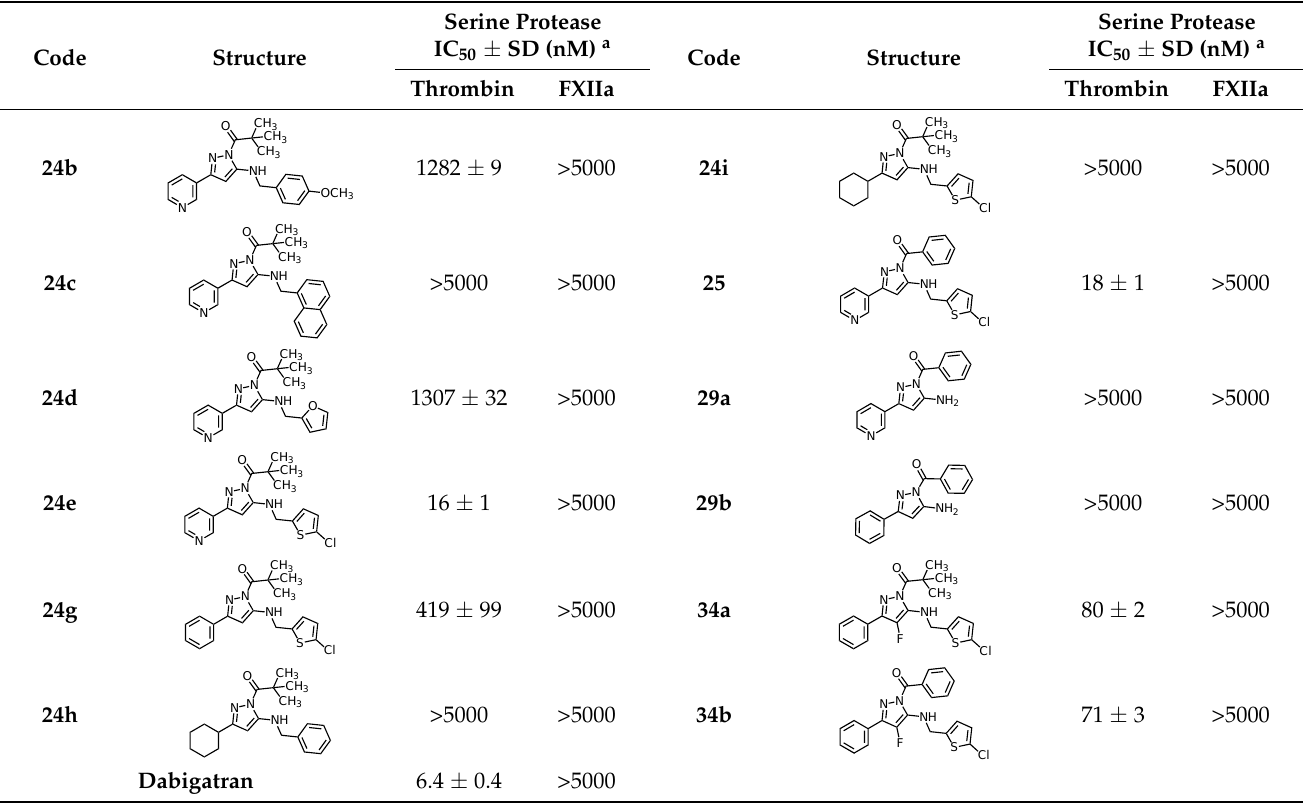
Table 3. Serine Protease Inhibition by Acylated Aminopyrazoles 24b – e , g – i , 25 , 29a , b , and 34a , b .